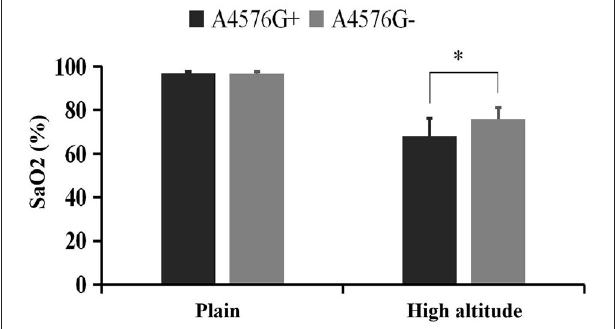
FIGURE 1 | Comparison of pulse oxygen saturation between A4576G+ and A4576G- groups. *Represents statistically significant comparation between A4576G+ group and A4576G- group at high altitude.